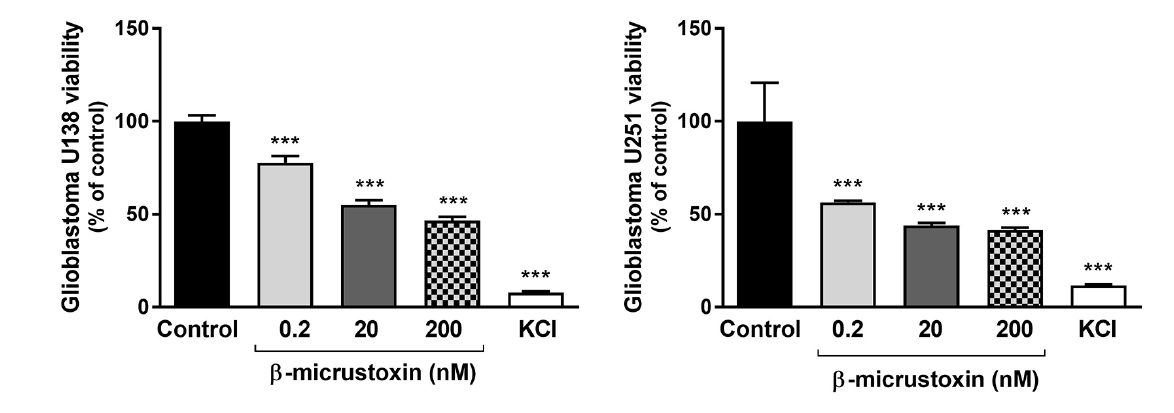
Figure 4. Viability of U138 and U251 glioblastoma tumor cells incubated in the absence (control) or presence of β-micrustoxin (0.2, 2, 200 nM). KCl (250 mM) represents positive control. One-way ANOVA and Bonferroni post hoc test: ***p < 0.001 in relation to the respective control group. N = 6-8/group, two full experimental blocks.